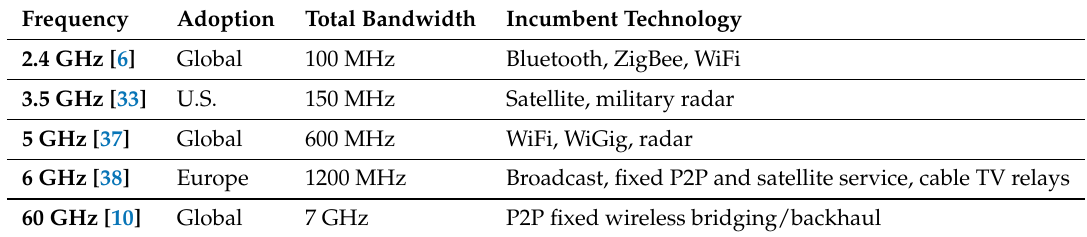
Table 5. NR-U unlicensed/shared